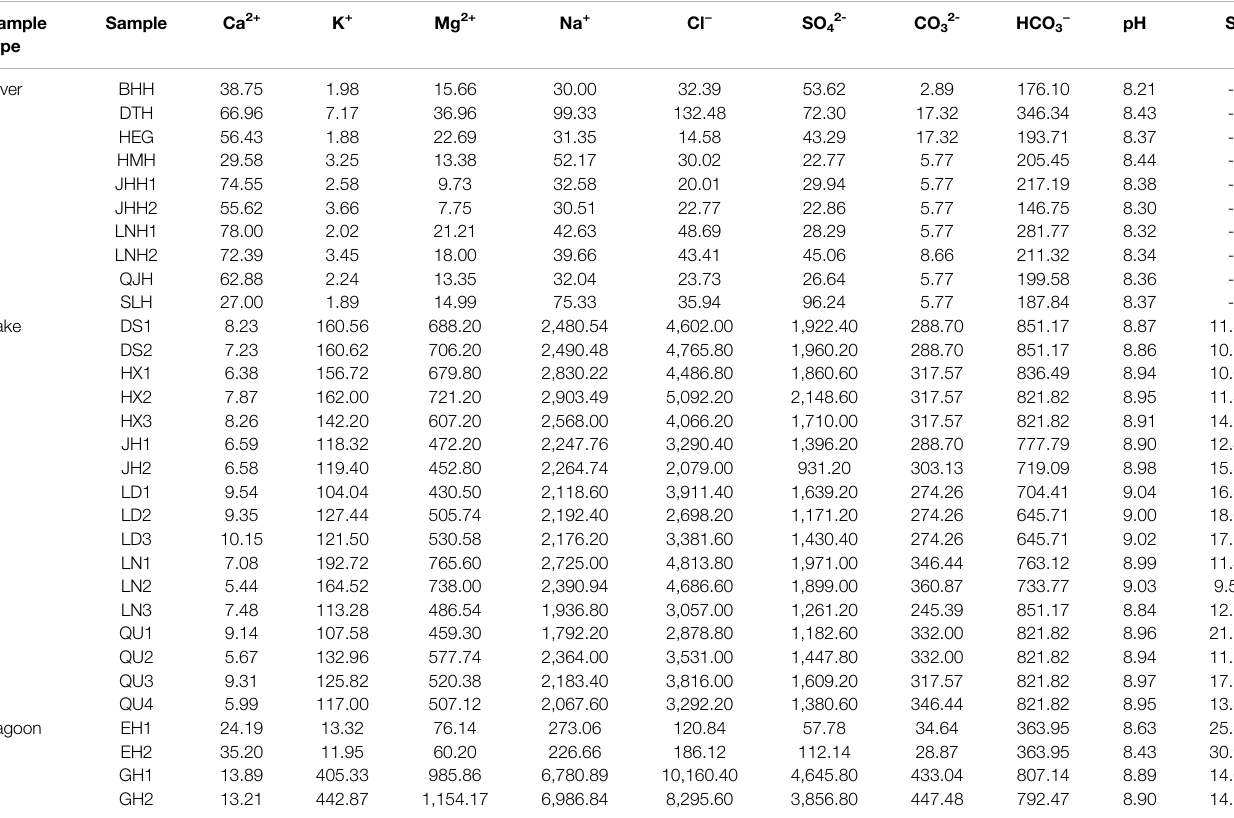
TABLE 1 | Hydrochemical properties and major chemical constituents of water samples from the study area (ionic concentrations in mg/L). Sample